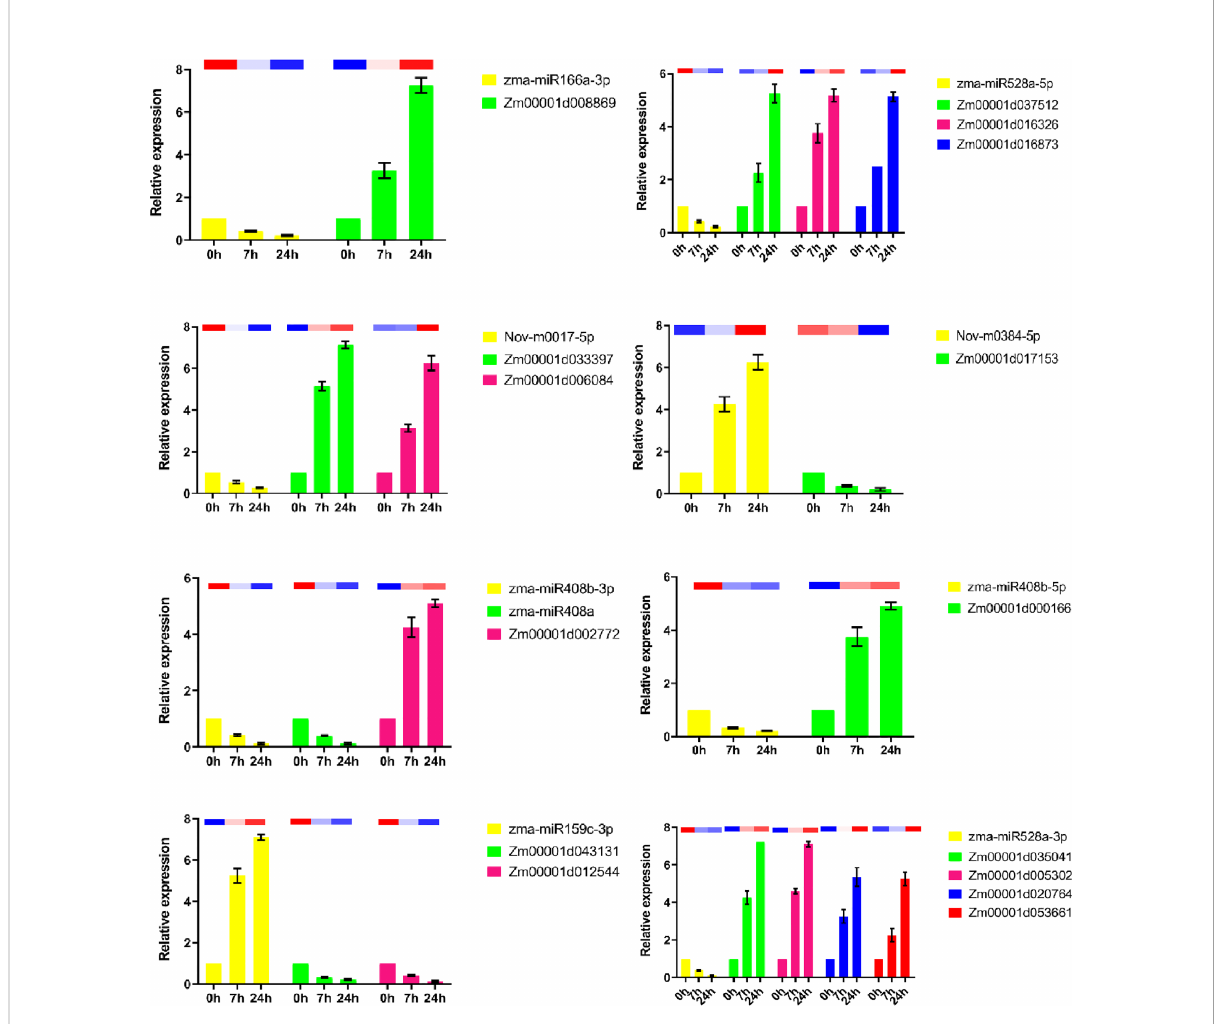
FIGURE 5 qRT-PCR analysis of DEMIs and DEMs in maize roots under drought stress. The 2 - DD Ct was used to calculate the fold change of expression in qRT-PCR analysis, with U6 and Actin as reference for miRNA and target genes, respectively. All experiments were repeated three times, and the expression data were log2 transformed before analysis. The error line is the standard error. The column charts represent qPCR data and heatmaps represent RNA-Seq